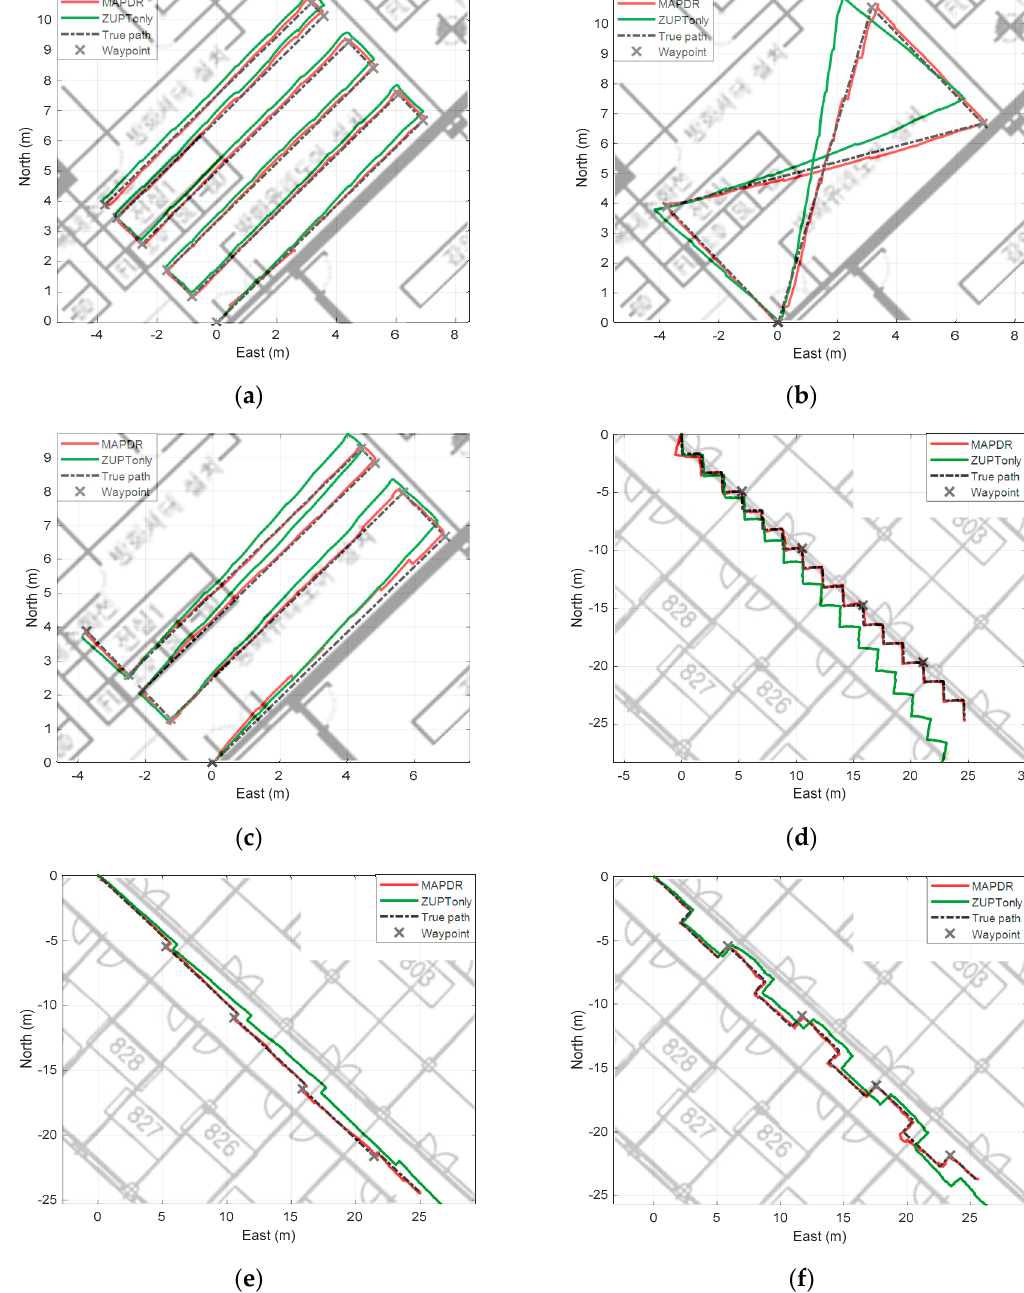
Figure 10. Experiment with MAPDR on the magnetic map ( a ) case 1 ( b ) case 2 ( c ) case 3 ( d ) case 4 ( e )